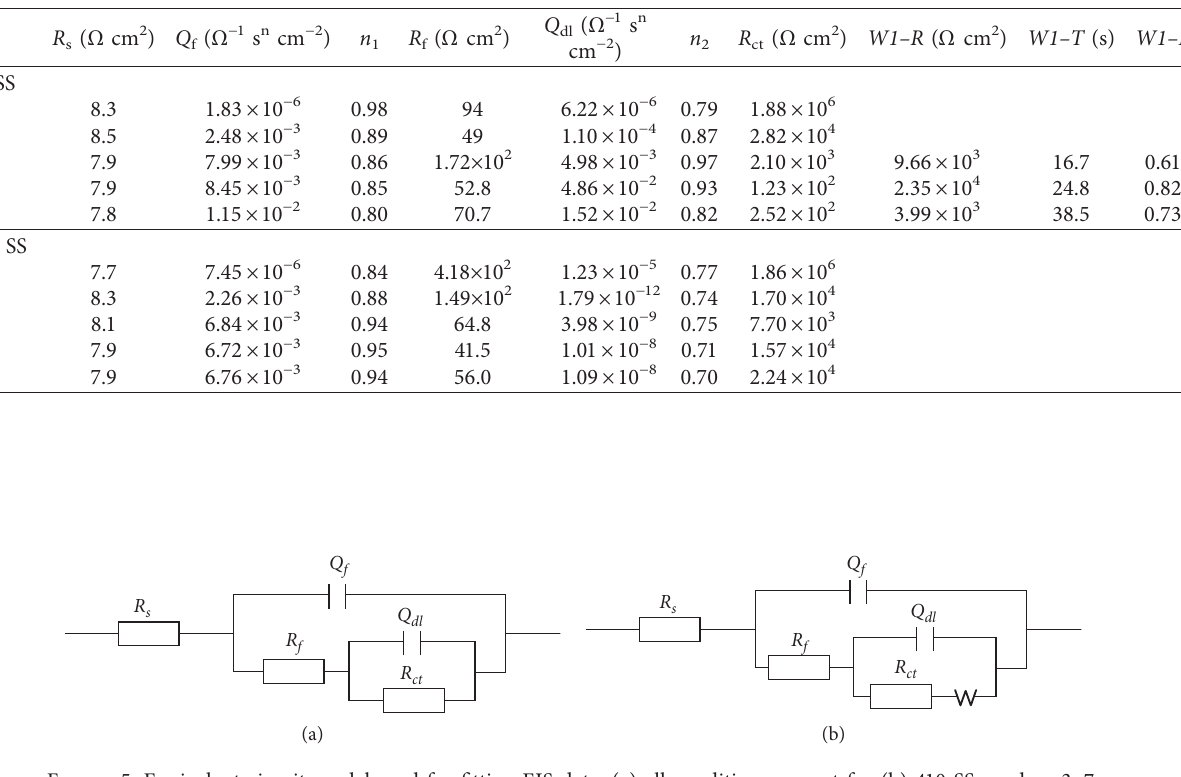
Figure 5: Equivalent circuit model used for fitting EIS data: (a) all conditions, except for (b) 410 SS on days 3–7.